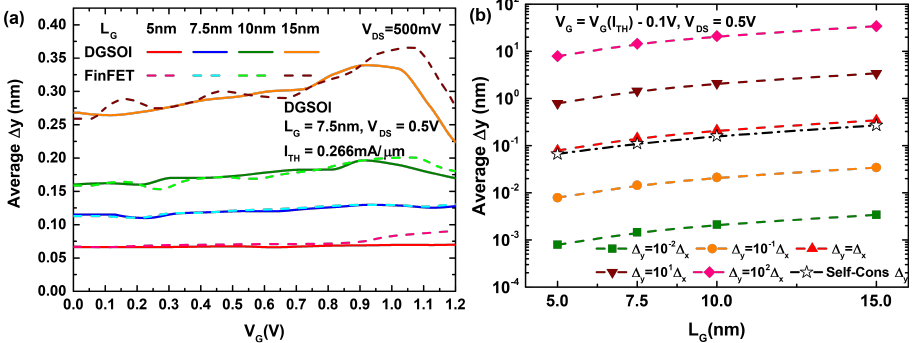
Figure 4. ( a ) Behavior of the average self-consistent ∆ y estimation as a function of V G for the DGSOI and FinFET with L G ranging from 5 nm to 15 nm. ( b ) Effect of gate length increase on the different ∆ y definitions (self-consistent and dependent on ∆ x